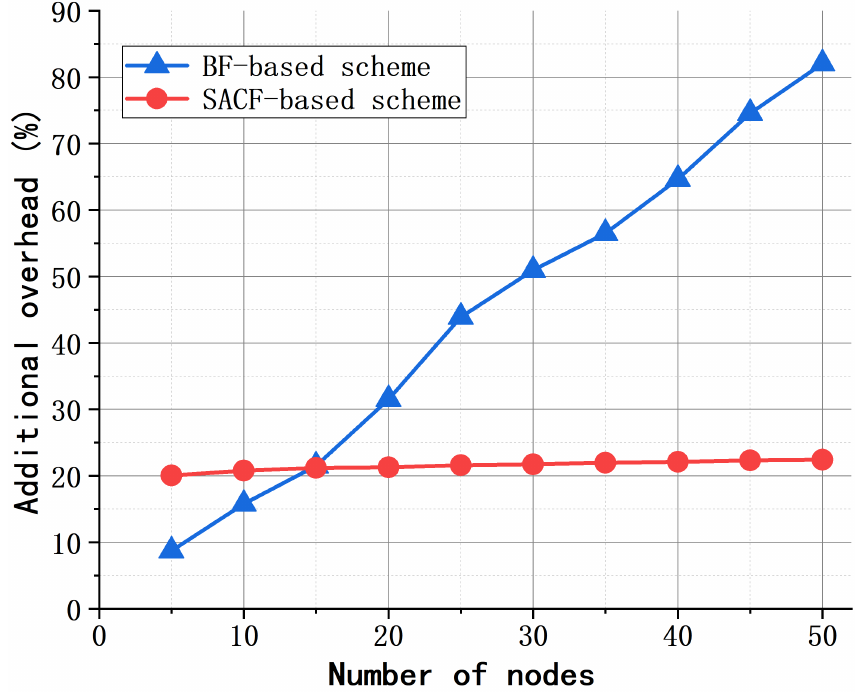
Figure 9. Additional forwarding overhead under varied network